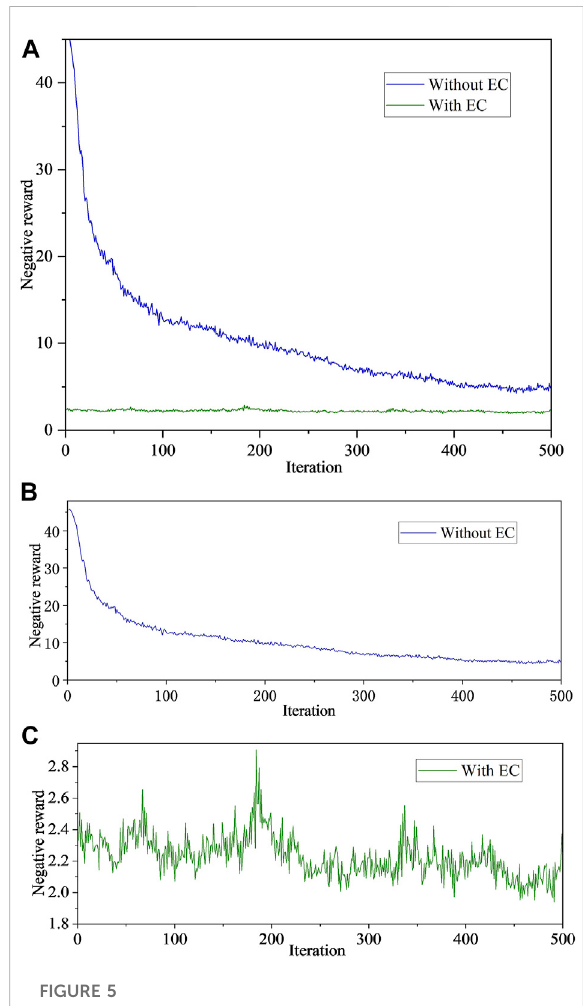
FIGURE 5 Learning curves for both Q-learning training processes without edge computing and with edge computing (ANN with standard